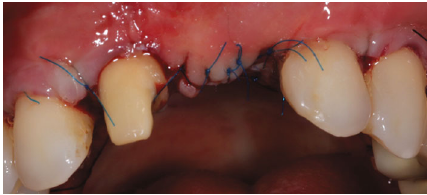
Figure 17: Final suturing of the fl ap with interrupted